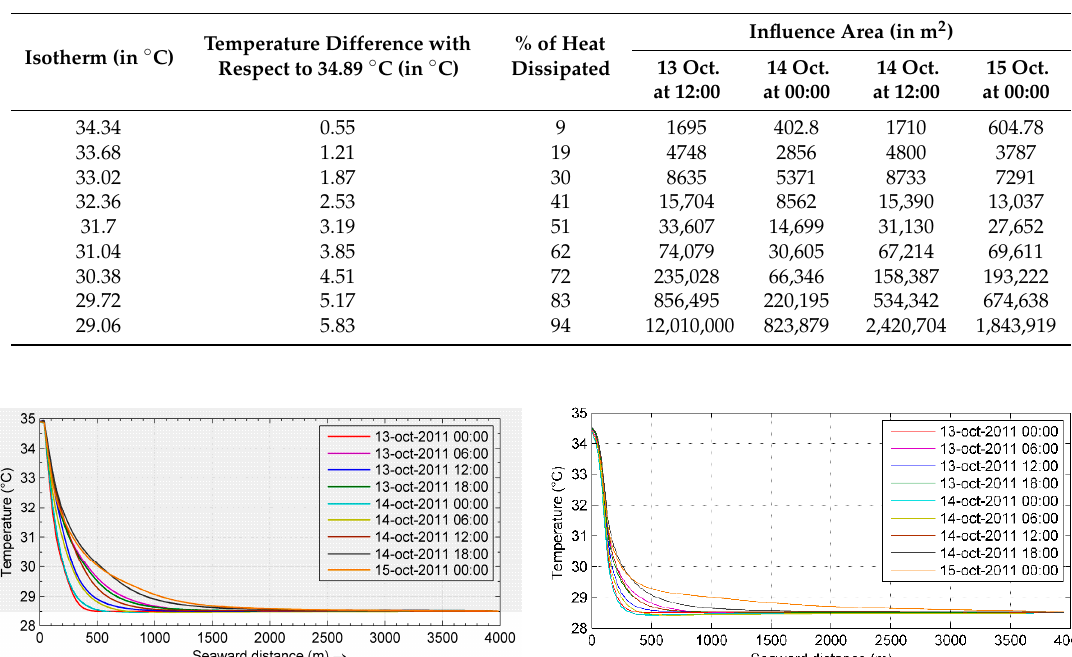
Table 5. Calculated influence areas of the thermal plumes per range of temperature.